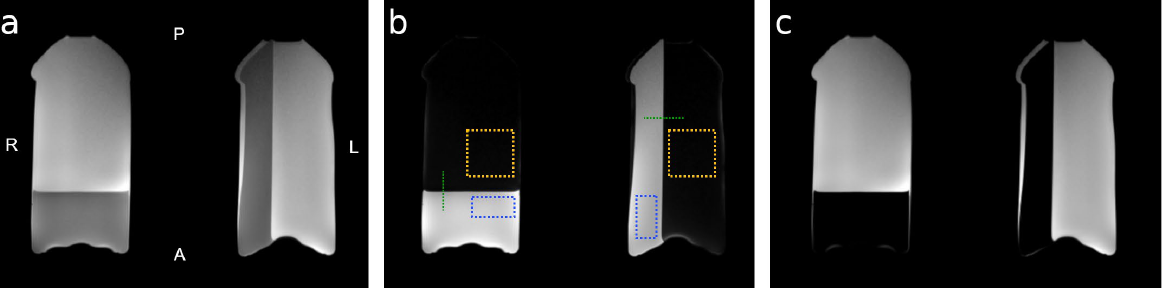
Figure 1. The physical layout of the agar/oil phantom and regions of interest (ROIs) used in analysis. In-phase ( a ), water (agar ( b )), and fat (oil ( c )) reference images of the agar-oil phantom obtained using a T1-weighted mDixon sequence are shown. The anterior/posterior (A/P) and left/right (L/R) orientation of the image is labeled in ( a ). The phantom was designed to provide agar gel boundaries orthogonal to the readout (anterior/posterior) and phase-encoding (left/right) directions. The agar gel is depicted in the water image ( b ). The dashed lines (green) indicate the position of the edge profiles used for MTF analysis. The dashed rectangles (blue) outlines indicate the location of the ROIs used in the noise level and spectral characteristic analysis. The dashed squares (yellow) outlines indicate the location of the ROIs used in the artifact level analysis.